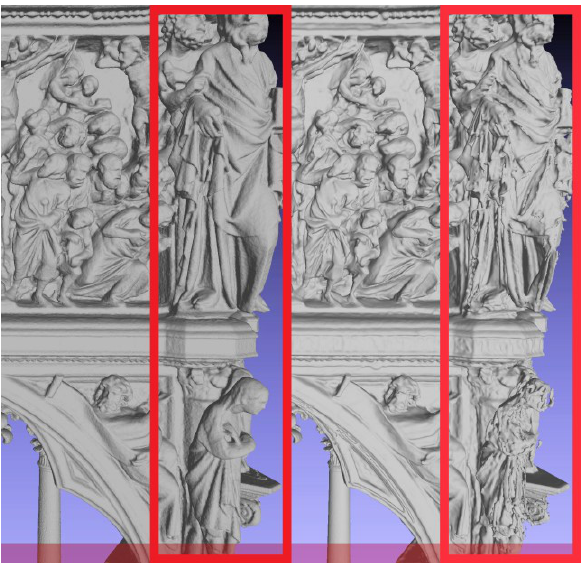
Figure 4: Meshes from data acquired with Z+F 5010C (left) and Leica C10